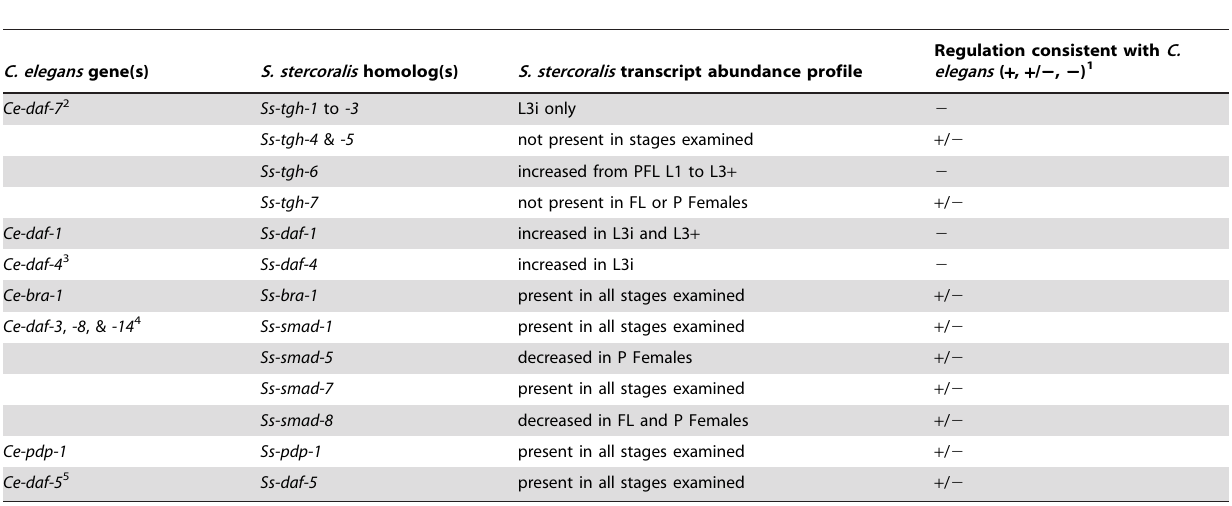
Table 3. Comparison of dauer TGF b signaling pathway homologs and transcript abundances in S. stercoralis and C. elegans